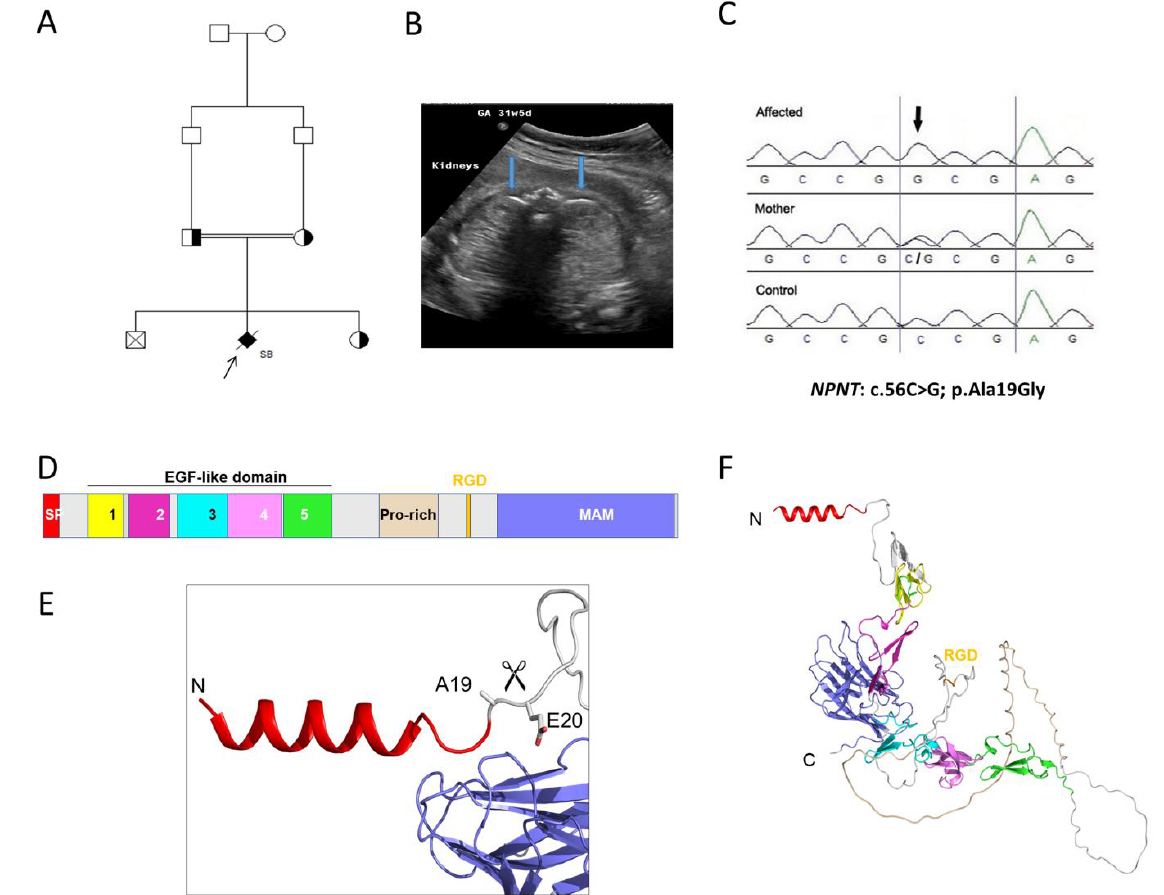
Figure 2. Family 2 with renal cystic dysplasia and NPNT variant. ( A ). Pedigree diagram of the stud- ied family with cystic dysplasia with the proband arrowed. ( B ) Transverse view of the fetal abdomen at 31 weeks’ gestation, showing the fetal kidneys (blue arrows), which appear hyperechoic bilaterally. ( C ) Sanger sequencing chromatograms of the NPNT missense variant (NM_001033047.3:c.56C>G; p.Ala19Gly) in the proband, mother, and healthy control. ( D ) Domain structure of NPNT. NPNT contains an N-terminal signal peptide (SP), five EGF-like domains (Ca2+-binding by EGF-2, -4, and -5), compositional bias (Pro-rich), integrin interaction (RGD domain), meprin, A5/NRP1, and protein tyrosine phosphatase µ (MAM) domain 1. ( E ) AlphaFold2 predicted a three-dimensional structure of the N-terminal signal peptide domain. The SignalP 5.03–predicted cleavage site between Ala19 and Glu20 is indicated by the scissors. ( F ) Overall three-dimensional structure of NPNT predicted by AlphaFold2. Domains are colored as in D.